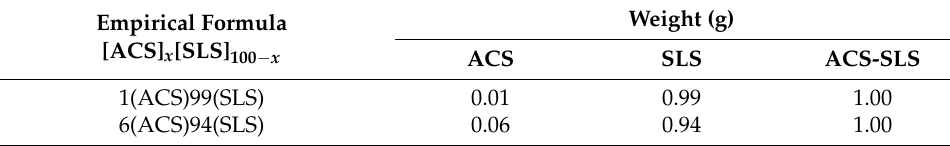
Table 1. Ratios of ACS to waste SLS glass